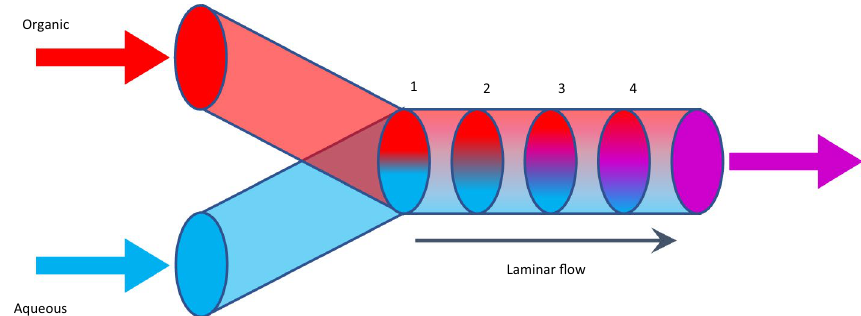
Figure 1. Controlled solvent displacement in a microfluidic mixer: (1) Organic (ethanol) and aqueous (PBS) phases enter the channel under laminar flow without mixing; (2) Microscopic features in the channel cause fluid streams to mix in a controlled fashion; (3) Intermingling of the phases increases through the mixer; (4) Fluids emerge, mixed as a stable